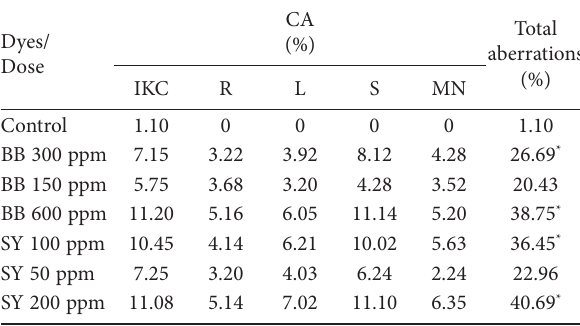
Figure 2. Increased of cell aberrations and decreased of mitotic index in meristematic cells of A. cepa exposed to Brilliant Blue and Sunset Yellow food